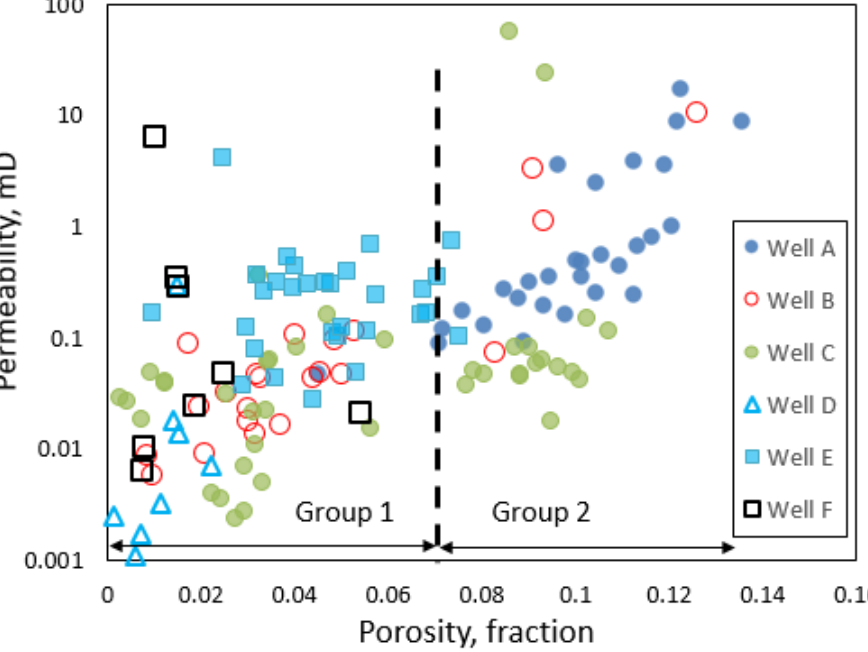
Figure 5. Cross-plot of helium porosity and helium permeability of 140 rock samples classified based on the wells from which they were extracted.